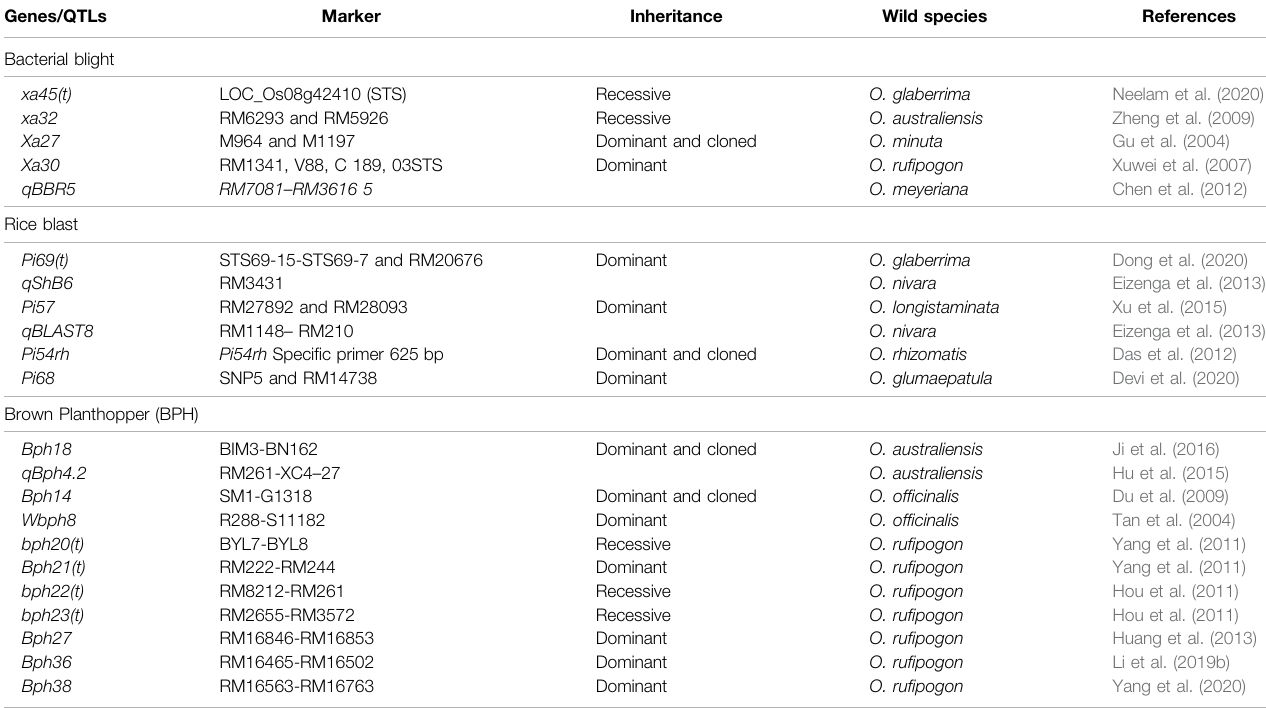
TABLE 2 | List of the key biotic stress resistance genes and QTLs identi fi ed within wild rice species.